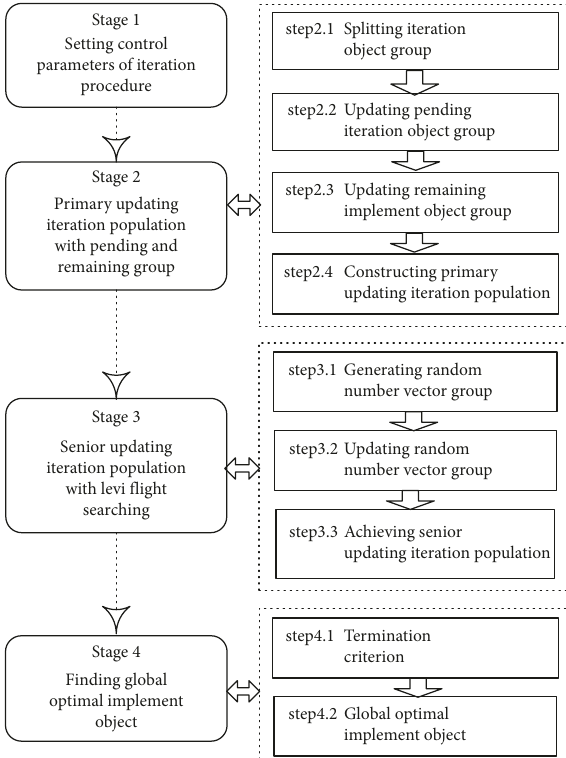
Figure 4: Illustration of asynchronous iteration